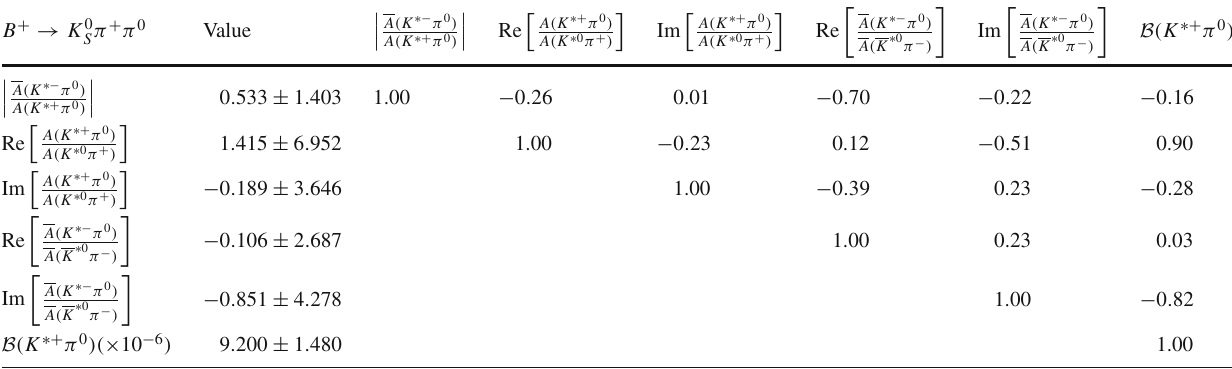
π + π 0 analysis S